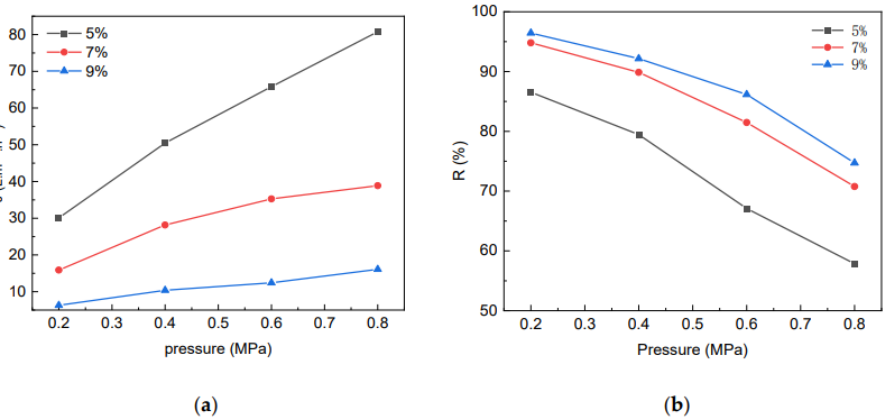
Figure 9. The effect of MCC content in casting liquid on Flux ( a ) of membrane and rejection rate for BSA ( b ).